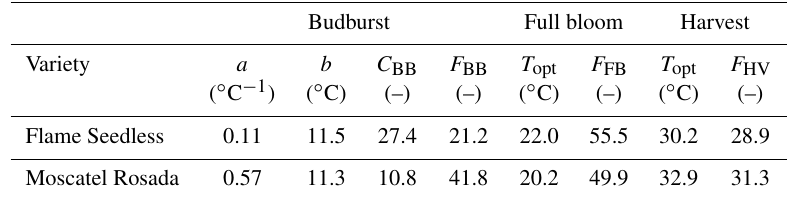
Table 3. Calibrated parameter values of the phenological models.